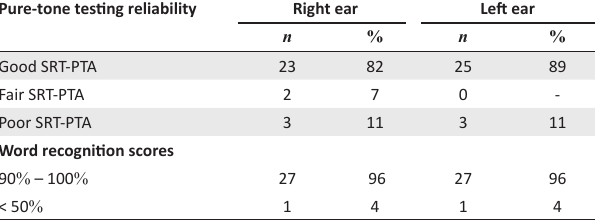
FIGURE 2: Types of hearing TABLE 3: Result of speech audiometry testing ( n = 28).